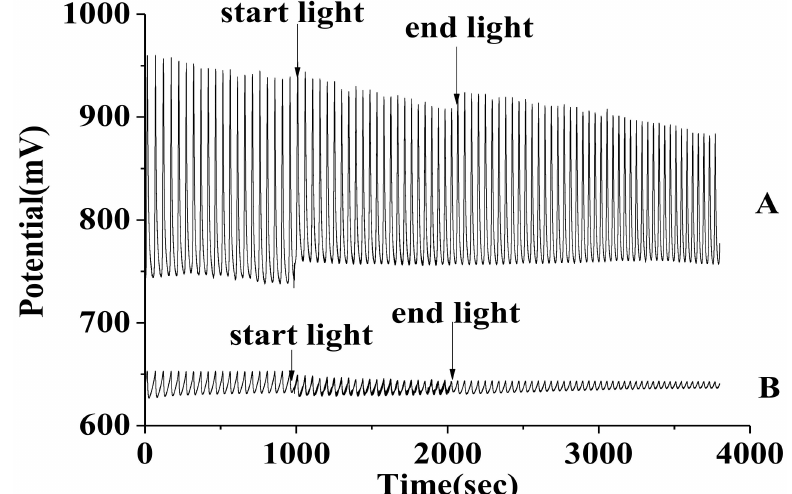
Figure 3. Typical potential oscillation profiles in the presence of light: ( A ) platinum electrode, ( B ) bromide ion selective electrode. Common conditions: [H 2 SO 4 ] 0 = 1.05 mol/L; [Acetone] 0 = 0.65 mol/L; [Glucose] 0 = 0.06 mol/L;[Sodium bromate] 0 = 0.08 mol/L; [[Cu](ClO 4 ) 2 ] 0 = 0.05 mol/L. Ultraviolet light applied at 245 nm with an intensity of 1250